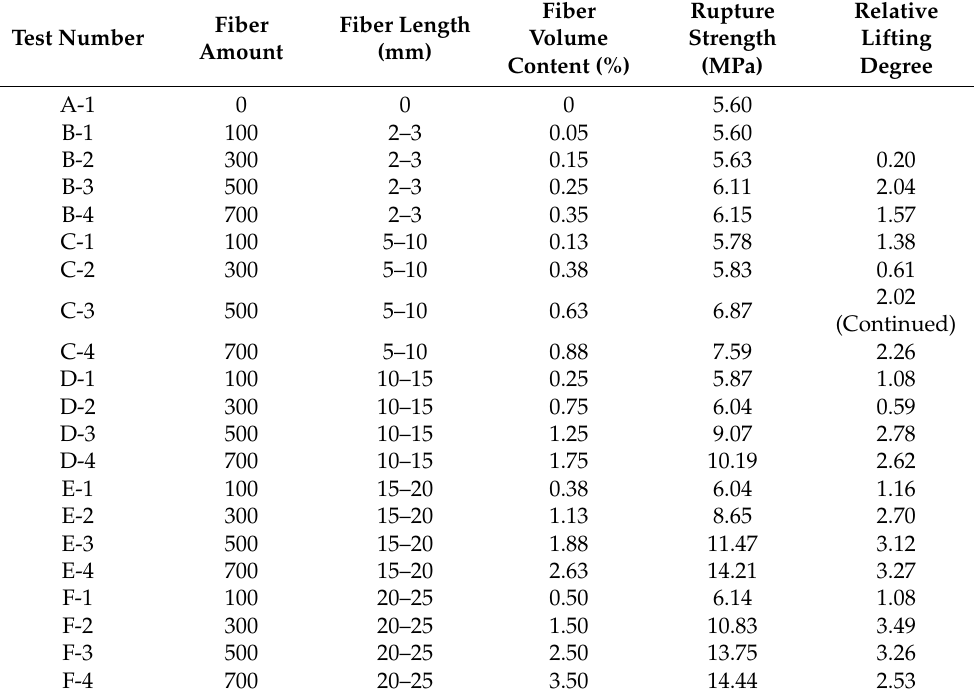
Table 3. Test results of relative improvement degree evaluation index.